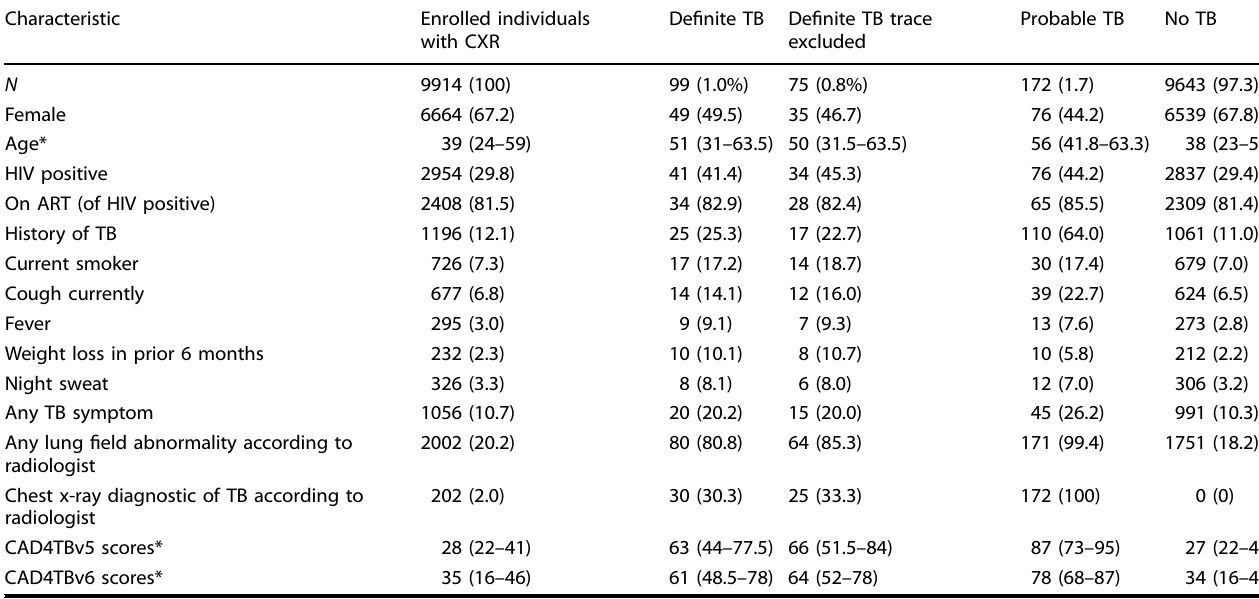
Table 1. Demographics, clinical and radiological characteristics of study participants.